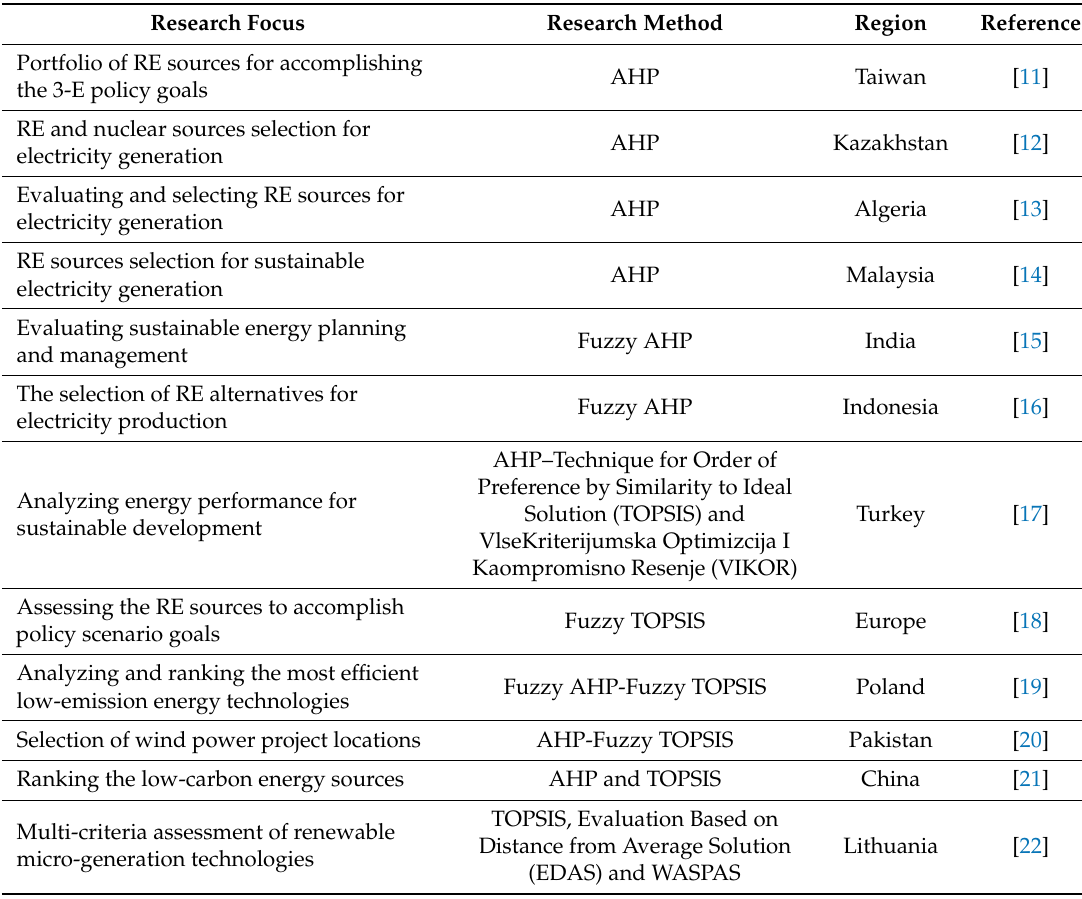
Table 1. The summary of various sustainable energy planning